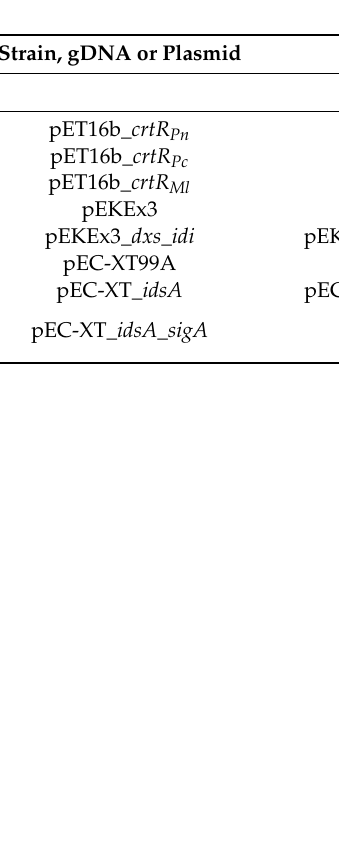
Figure 6. Biosensor-based di ff erentiation between strains accumulating di ff erent GGPP concentrations. The intracellular GGPP concentrations are given in mM, and the GFPuv signals in mean fluorescence intensities were normalized to autofluorescence. Strains WT (pEPR1_P crtE ), GGPPA (pEPR1_P crtE ) and GGPPB (pEPR1_P crtE ) were cultivated in CGXII (100 mM Gluc + 100 µ M IPTG) and data were taken after 12 h. Statistical significance was calculated with paired Student t-test (two-tailed); *: p -value <